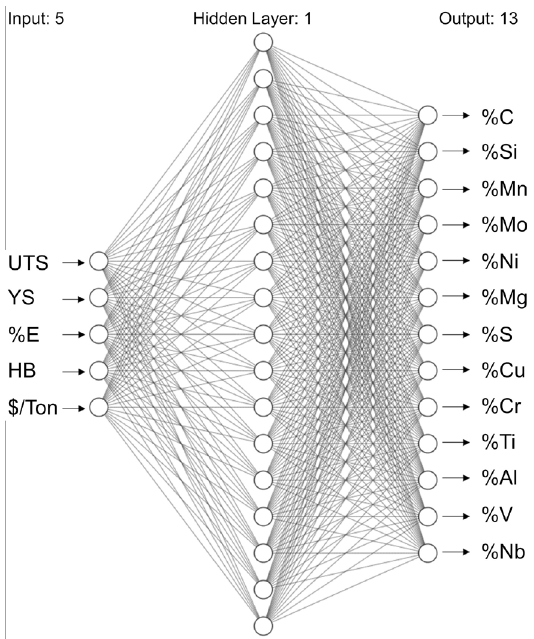
Figure 2. Architecture of the first